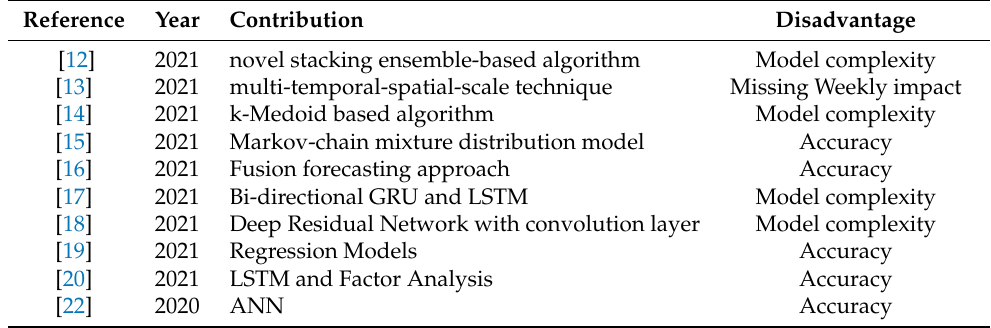
Table 1. Literature summary.